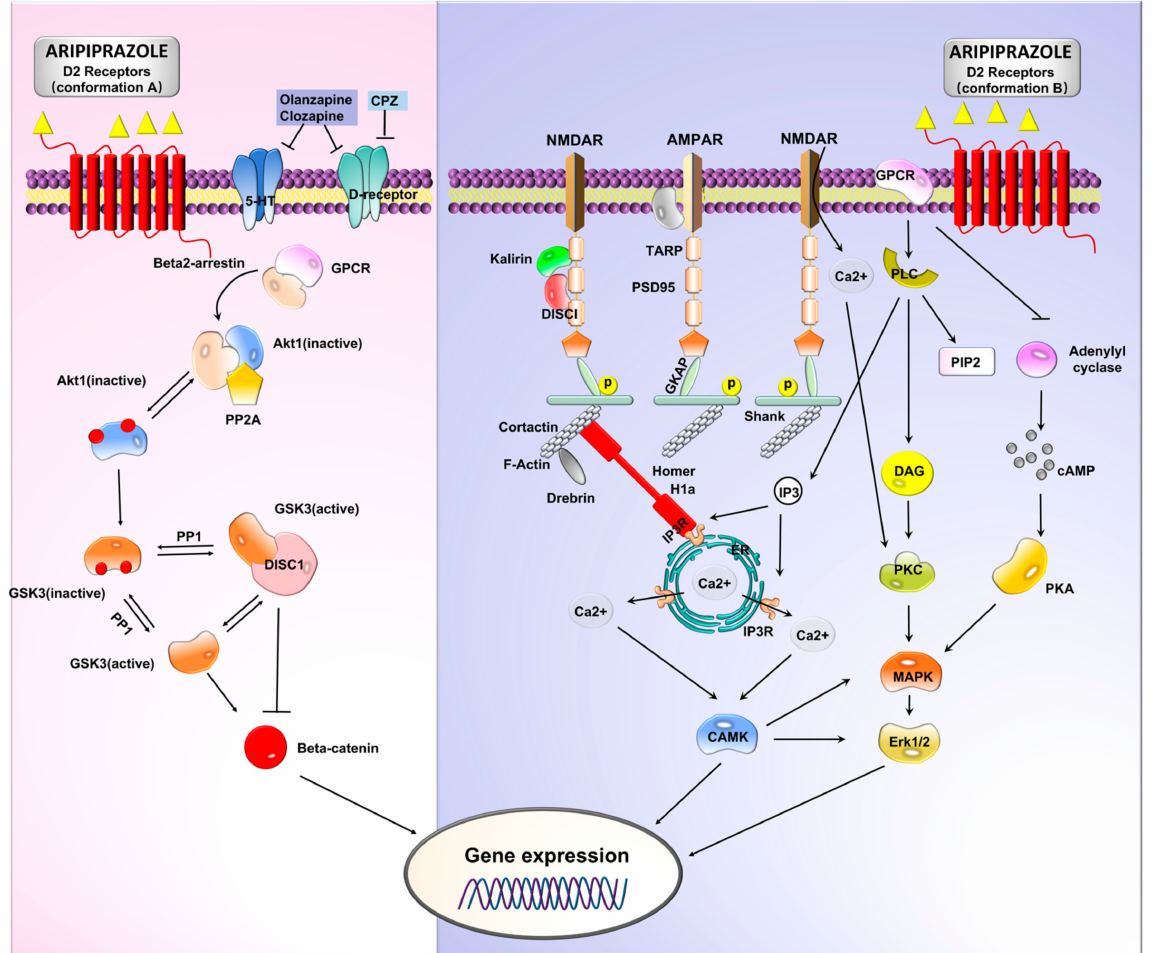
Figure 5. ARP postsynaptic functional selectivity. ARP causes what is referred to as functional multiplicity at D2 receptors’ postsynaptic downstream pathways. One mode of action of functional selectivity might be the preferential binding to different D2 receptor conformations, which have been demonstrated to activate differential transduction pathways according to the neuronal subtypes in which they are expressed. Postsynaptic scaffolding/adaptors and effectors might be affected in a different manner by each D2 receptor conformation-related pathway selectively activated by ARP. PSD-95 (postsynaptic density protein-95 kD), TARP (transmembrane AMPA receptors regulating protein or stargazing), MAPKs (mitogen-activated protein kinases), nMDAR (N-methyl-D-aspartate glutamate receptor), PDE4 (phosphodiesterase 4), GKAP (guanylate kinase-associated protein), and AMPAR ( α -amino-3-hydroxy-5-methyl-4-isoxazolepropionic acid glutamate